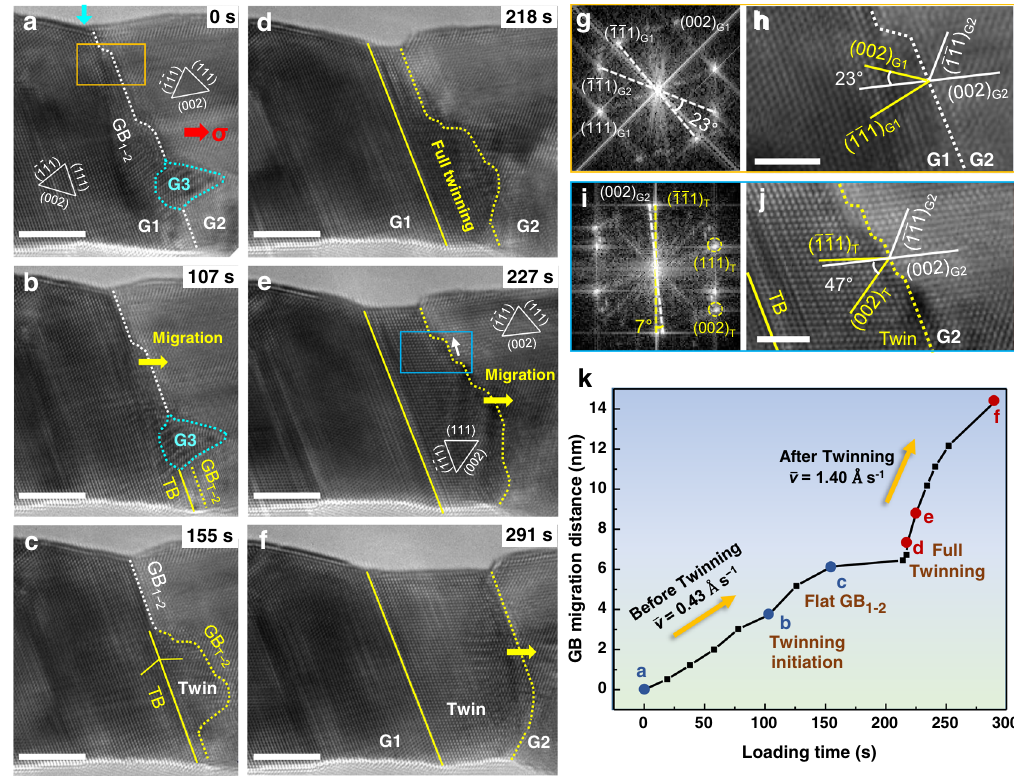
Fig. 1 Twinning-assisted dynamic adjustment of grain boundary structure and mobility. a As-fabricated Au bicrystal with a 23° [1 (cid:1) 10] tilt grain boundary (GB) denoted as GB 1-2 (indicated by the white dotted line). Tensile loading was applied at a constant rate of ~0.005 nm s − 1 along the axial direction (shown by the red arrow), with a slanted angle of ~12° to the (002) plane of G2. b Rightward migration of GB 1 – 2 indicated by the yellow arrow. Meanwhile, a deformation twin nucleated at the intersection of GB 1 – 2 and the bottom free surface, transforming the local GB segment to GB T-2 with a misorientation of 47°, as indicated by the yellow dotted line. c Lateral expansion of the GB-emitted deformation twin sandwiched by GB T-2 and TB. d – f Fully transformed GB T-2 with enhanced mobility after deformation twinning, which adjusted from a curved geometry to a smooth one upon further migration with facets lateral motion in a disconnection mode, as indicated by the white arrow in ( e ). g – j Fast Fourier transform (FFT) patterns and enlarged images of the GB before ( g and h ) and after ( i and j ) deformation twinning. The GB regions are marked by the orange and blue boxes in ( a ) and ( e ), respectively. k Quantitative measurement of the GB migration distance with increasing loading time. The deformation snapshots a – f were highlighted by solid circles in the plot. A static surface step (indicated by the light blue arrow in a ) was selected as the reference to evaluate the migration distance of the GBs. Scale bars: a – f 5 nm; h , j 2